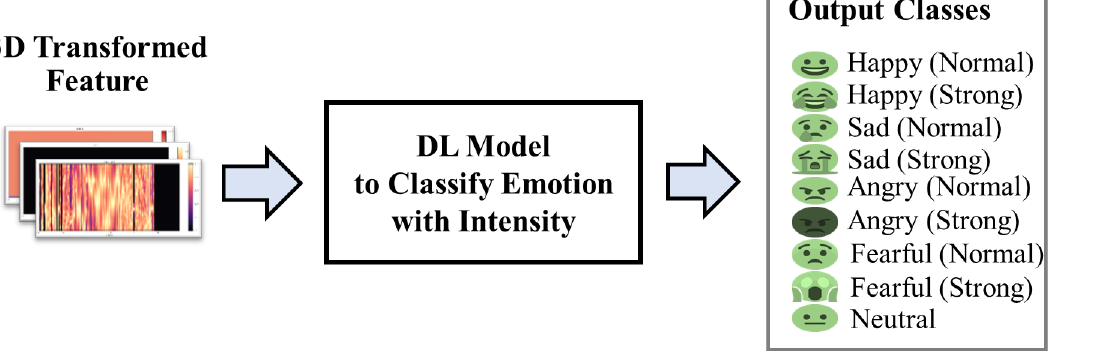
Figure 3. Single DL framework to classify emotion with intensity from 3D transformed speech